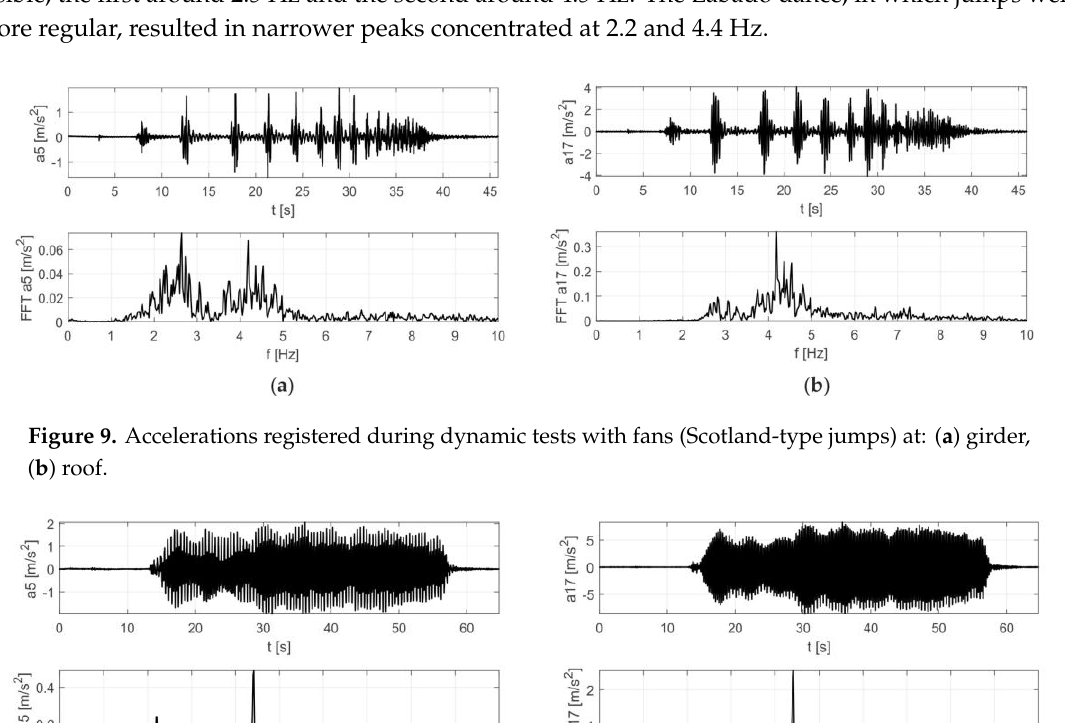
Figure 8. Dynamic tests with fans: ( a ) experimental setup, ( b ) scheme showing the arrangement of people during tests (orange color—rows indicating the most unfavorable fan positions).